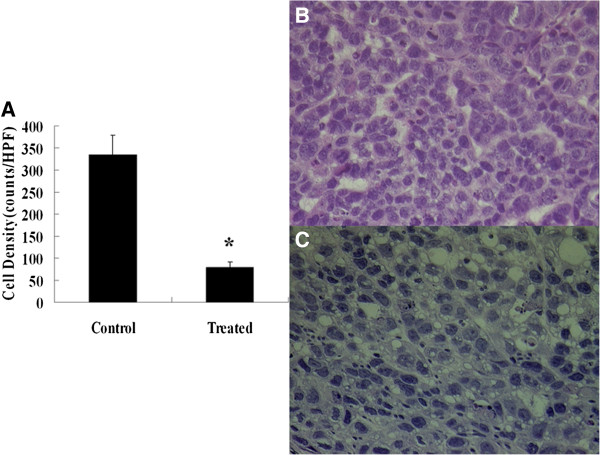
Histopathologic analysis of tumor cell nuclei density. (A) The graph displays the mean density of tumor cell nuclei in the control and treated tumors (* = p < .001). (B) and (C) Representative photomicrographs of hemotoxylin and eosin stained sections of the control (B) and treated (C) tumors. Staining revealed microstructural changes in the tumor treated with adriamycin, including a decreased density of cell nuclei, and cytoplasmic and nuclear vacuolation, and clumping of nuclear chromatin (original magnification, ×400).